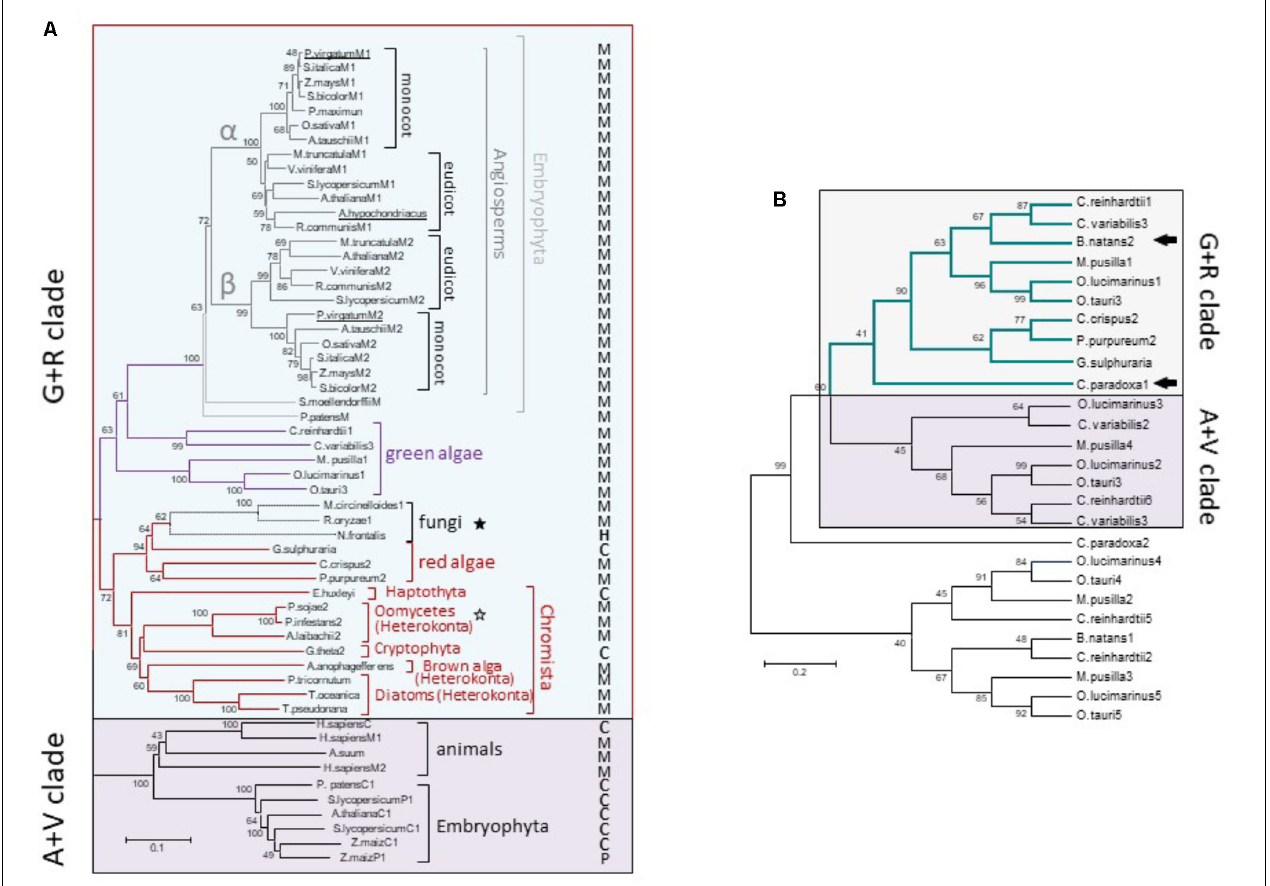
FIGURE 4 | Phylogenetic tree of G+R clade of Class I-ME (A) and inclusion of C. paradoxa and B. natans MEs (B) . (A) Maximum likelihood tree of ME sequences focusing on the G+R clade. Methods are the same as in Figure 3 [WAG + G(2.0533) + I(2.6198) model]. The tree is drawn to scale, with branch lengths measured in the number of substitutions per site. M, P, H, and C indicate mitochondrial, plastidic, hydrogenosomal, or cytosolic location, respectively. Stars indicate non-photosynthetic organisms with proved (empty stars) or not proved (filled stars) photosynthetic past. (B) Maximum likelihood tree constructed (WAG model) with 240 amino acid ME sequences from green and red algae along with the available translated protein regions from the glaucophyte Cyanophora paradoxa and the secondary photosynthetic Bigelowiella natans (see Supplementary Table S1 for details). Arrows indicate C. paradoxa and B. natans sequences included into the G+R clade. In both trees, numerals indicate support of branches with 500 boostrap